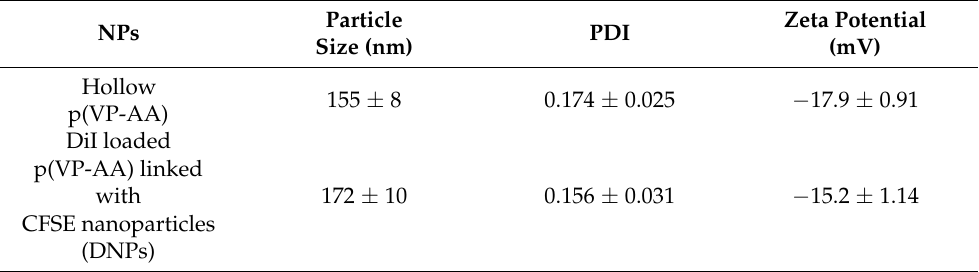
Table 1. Characteristics of hollow p(VP-AA) and labeled DNPs.